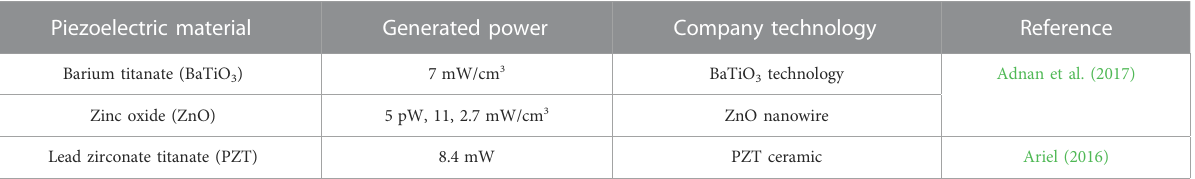
TABLE 2 Power generation in fl oor building techniques for energy